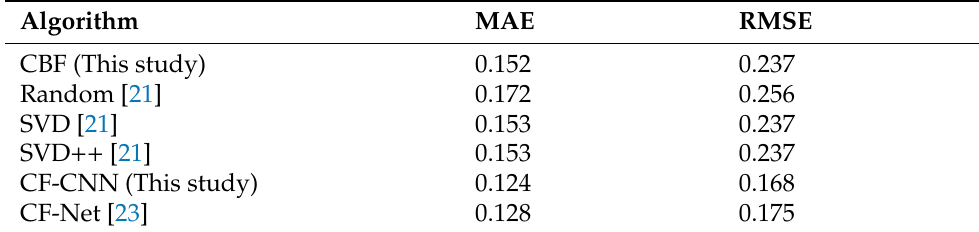
Table 6. Performance statistics with di ff erent TERS